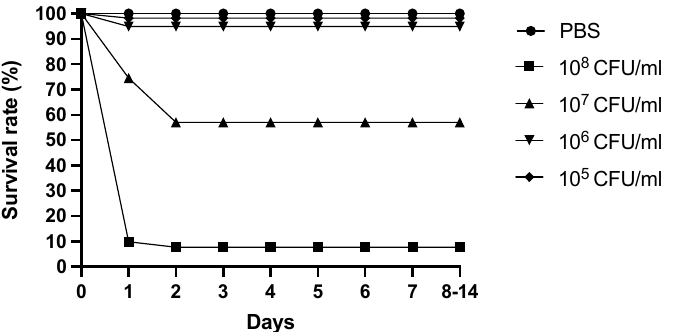
Figure 1. Survival of B. areolata challenged with different concentrations of FP17. Phosphate buffered saline was used as negative control.